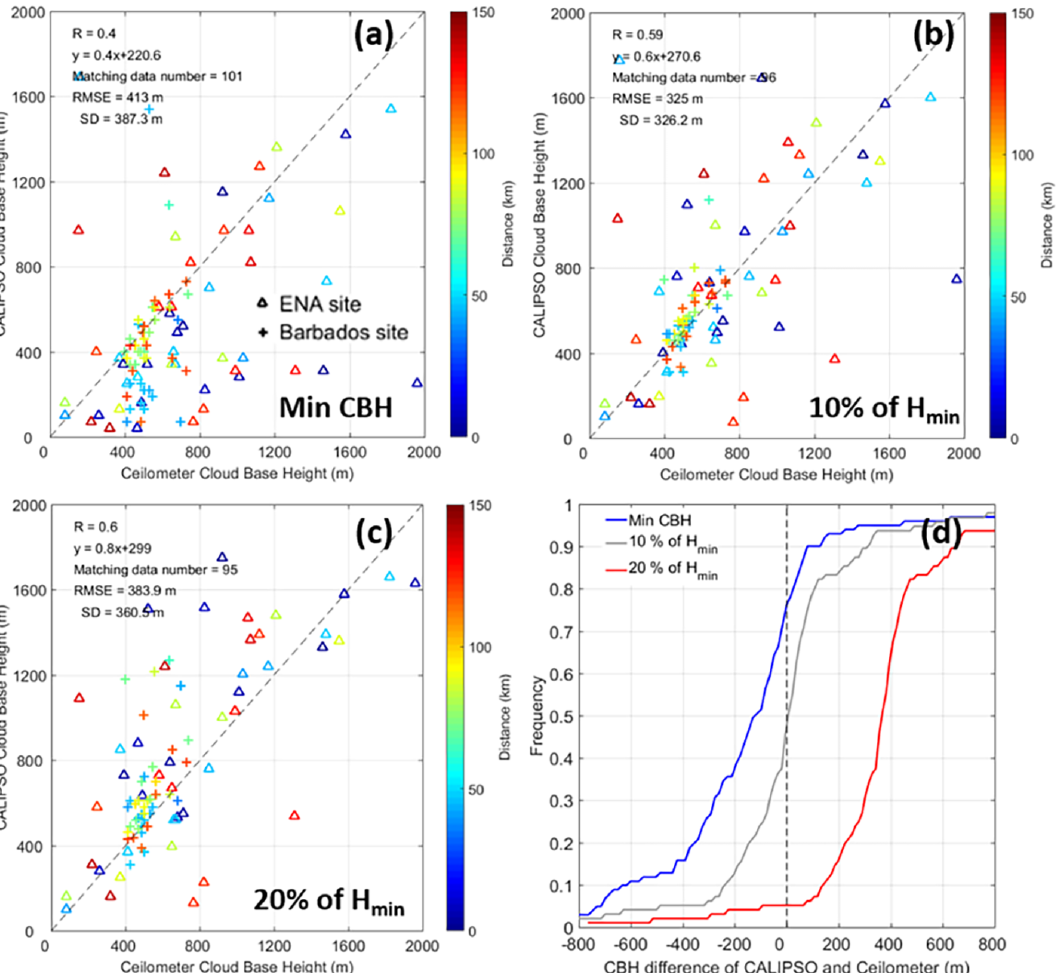
Figure 4. (a) Scatter plot of CALIPSO CBH (the minimum CBH for each 1 ◦ scene) and ceilometer CBH at two marine sites in 2017. The triangle represents the data for the ENA site, and the crosses represent the data for the Barbados site. The color represents the shortest distance from the CALIPSO ground track to the ceilometer site. R is the Pearson correlation coefficient, y indicates the linear fitting relationship between ceilometer CBH and CALIPSO CBH, matching data number is the data amount of the scatter plot, RMSE is the root-mean-square error, and SD is the standard deviation. Panels (b) and (c) are the same as panel (a) but for CALIPSO CBH at 10% quantile of H min and 20% quantile of H min , respectively. (d) Cumulative distribution of the difference between CALIPSO CBH and ceilometer CBH at two sites in